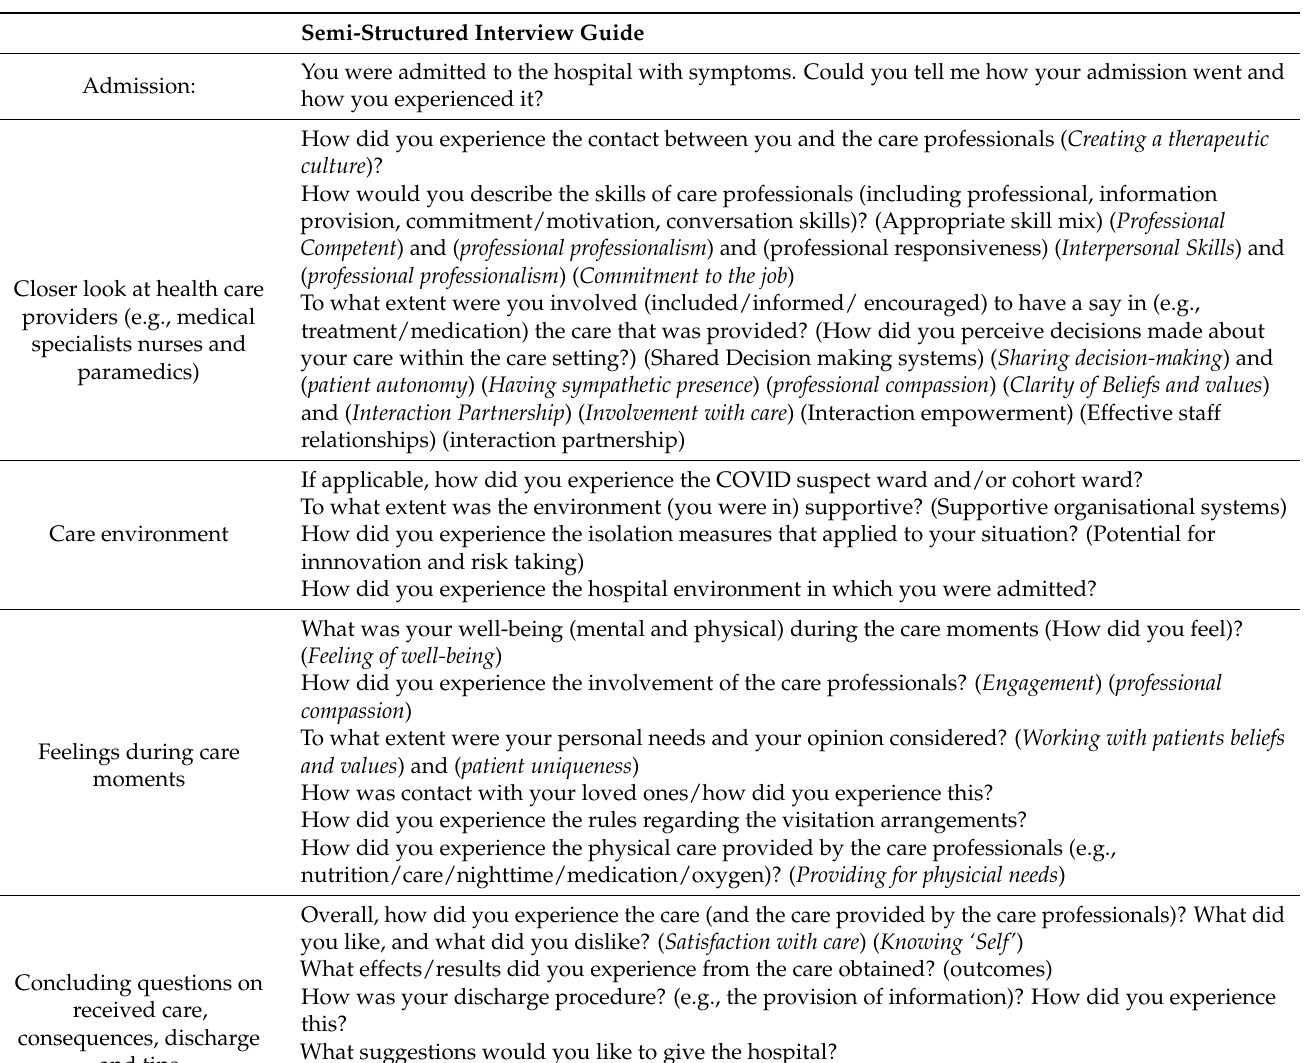
Table A1. Semi-structured interview